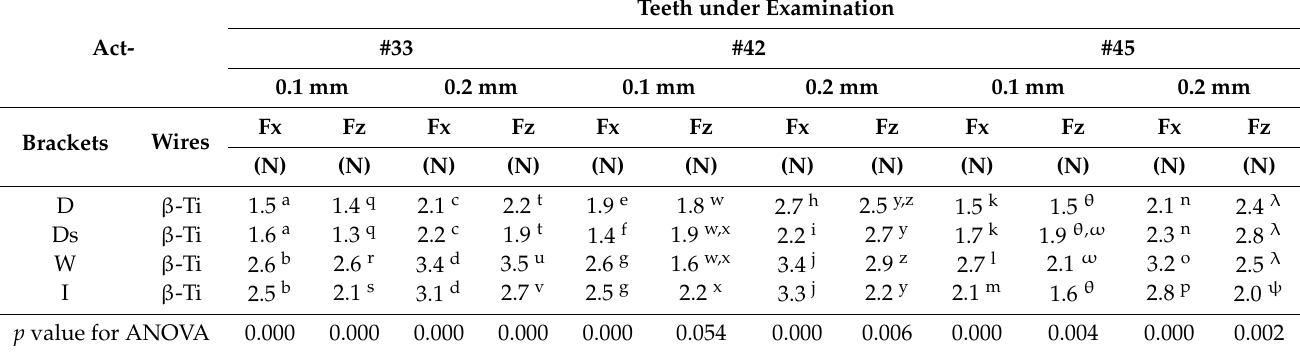
Table 7. Intrusion/extrusion and orovestibular force values generated during negative activation at a specific tooth (canine, lateral incisor and premolar) area using the four different bracket appliances combined with the beta-titanium wire at 0.1 mm and 0.2